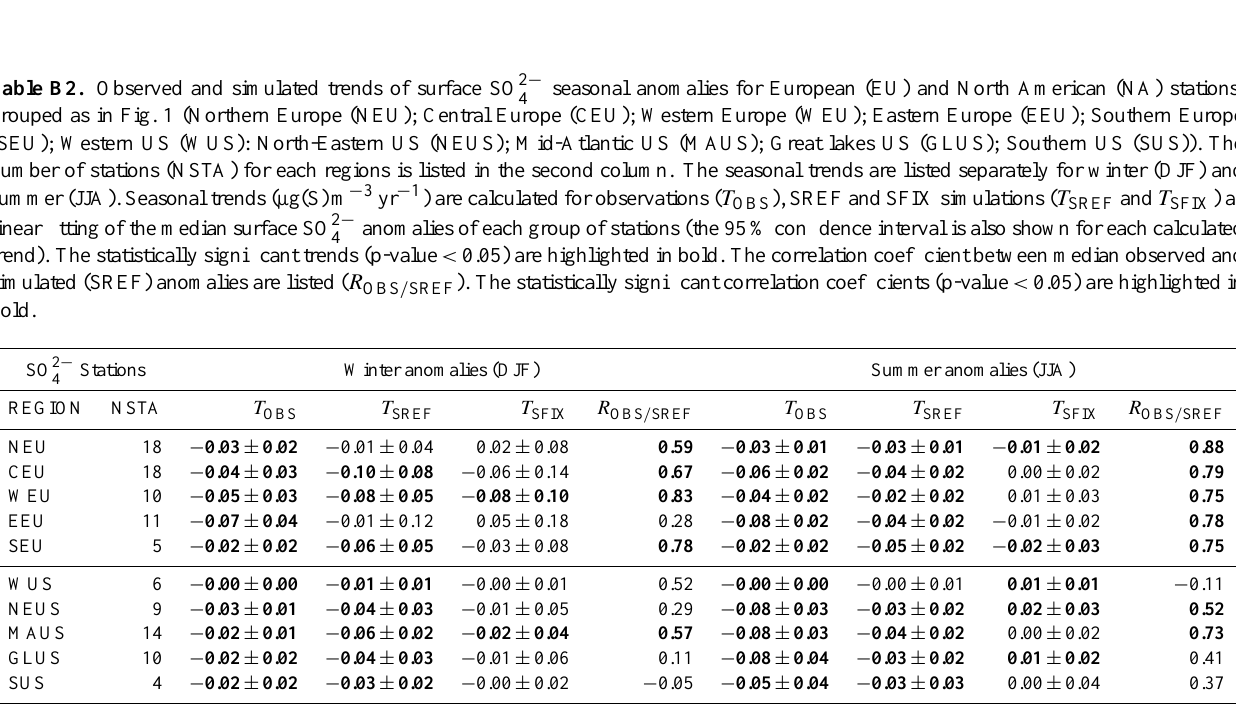
0.11 ± 0.18 − 0.02 ± 0.23 − 0.07 ± 0.26 0.66